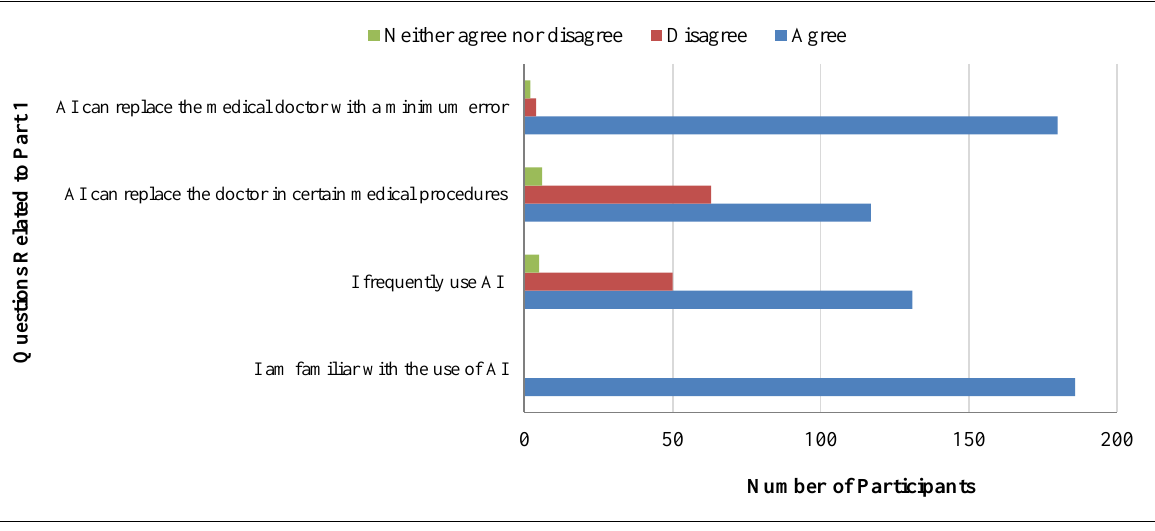
Figure 4. Knowledge of